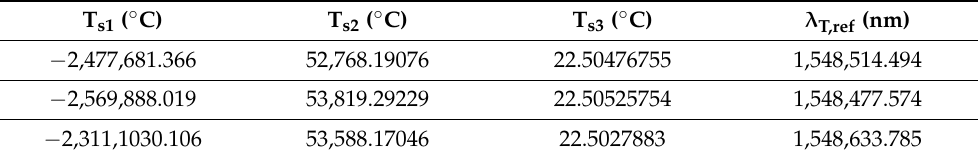
Table 3. Calibration coefficients.